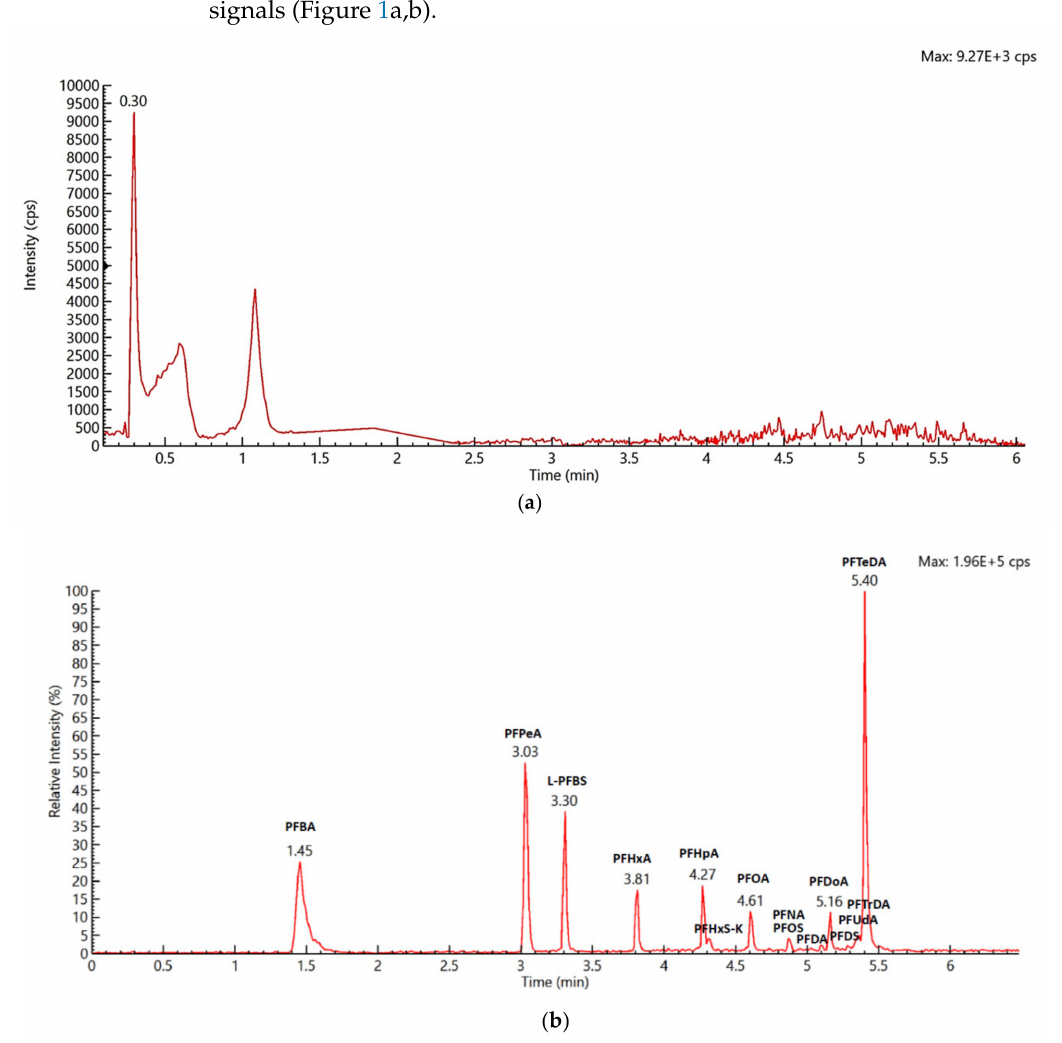
Figure 1. Selectivity of per and polyfluorinated alkyl substances (PFAS) in milk: ( a ) TIC of milk matrix blank; ( b ) TIC of spiked